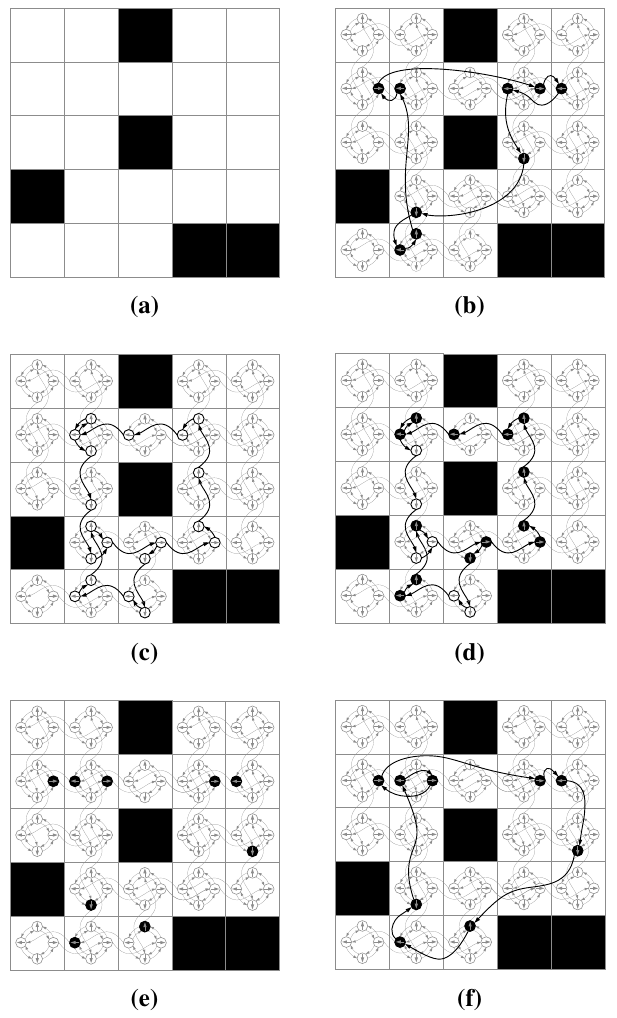
( a ) a simple test map, where obstructed cells are represented in black and traversable ones in white. Candidate sensing configurations are defined over poses in the cells , π, 3 π } and have identical φ and r ( r = 2 cells, φ = π such that Θ = { 0 , π ). In this example 2 2 2 setup, the movement from one cell to the next requires 1 s, the rotation of π requires 0 . 5 s, 2 and a sensing action takes 4 s; ( b ) the optimal solution, when traveling and sensing costs are considered at the same time. Here, the curved arrows represent the minimum distance from a sensing configuration to the next on the underlying graph. In this case, the total exploration time is 52 . 5 s ( 16 . 5 s for traveling and 36 s for sensing). ( c , d ): Here, traveling time is minimized first (see Section 5.1). (c) the minimum cost closed path from which all cells can be observed is calculated; (d) and then the minimum set of sensing configurations is selected, yielding an overall exploration time of 66 . 5 s. ( e , f ): Here, sensing time is minimized first (see Section 5.2). (e) the set of minimum cost sensing configurations is selected from which all cells are observable; (f) and then connecting them with the shortest closed path. This approach yields to an overall exploration time of 55